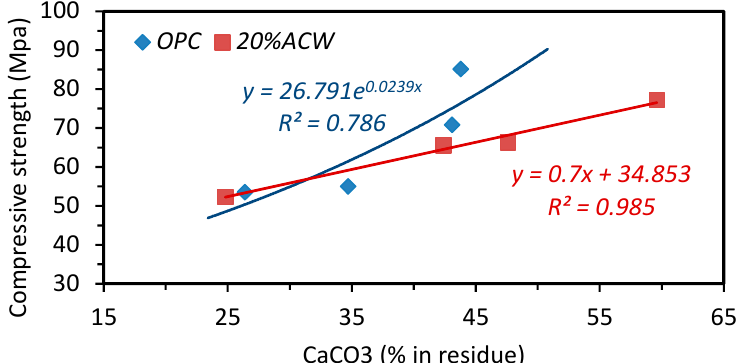
Figure 11. Carbonate content vs. compressive strength.